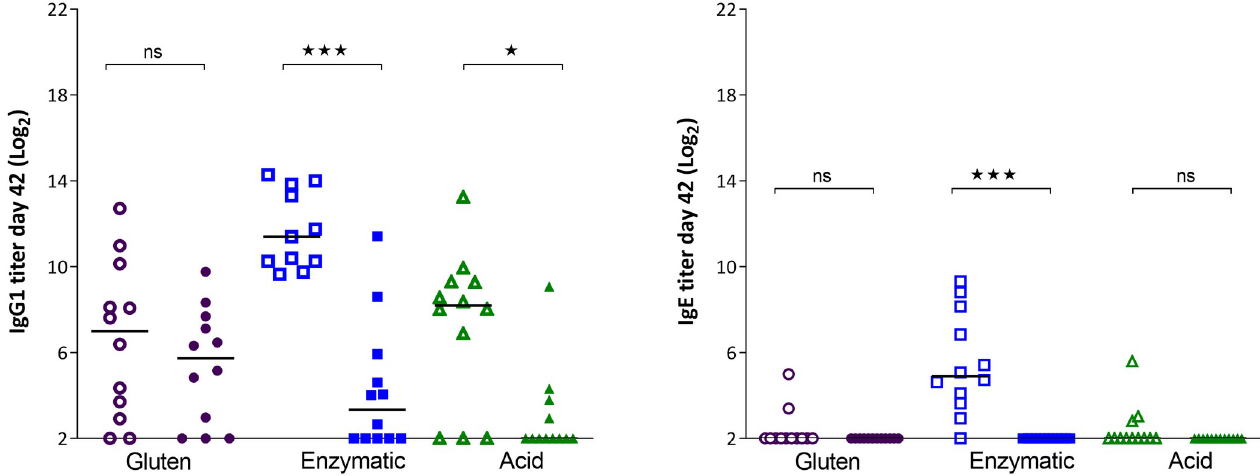
Fig 9. Specific antibody response in gluten na ï ve rats (open symbols) and gluten tolerant rats (closed symbols) after oral dosing for 35 days with 20 mg gluten, enzymatic or acid hydrolyzed gluten. � p < 0.05, ��� p < 0.001.